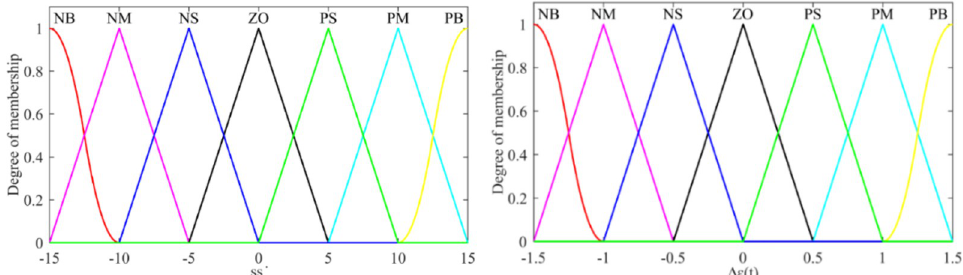
Fig 12. Membership function of fuzzy system. (a) Membership function of fuzzy input, (b) Membership function of fuzzy output.